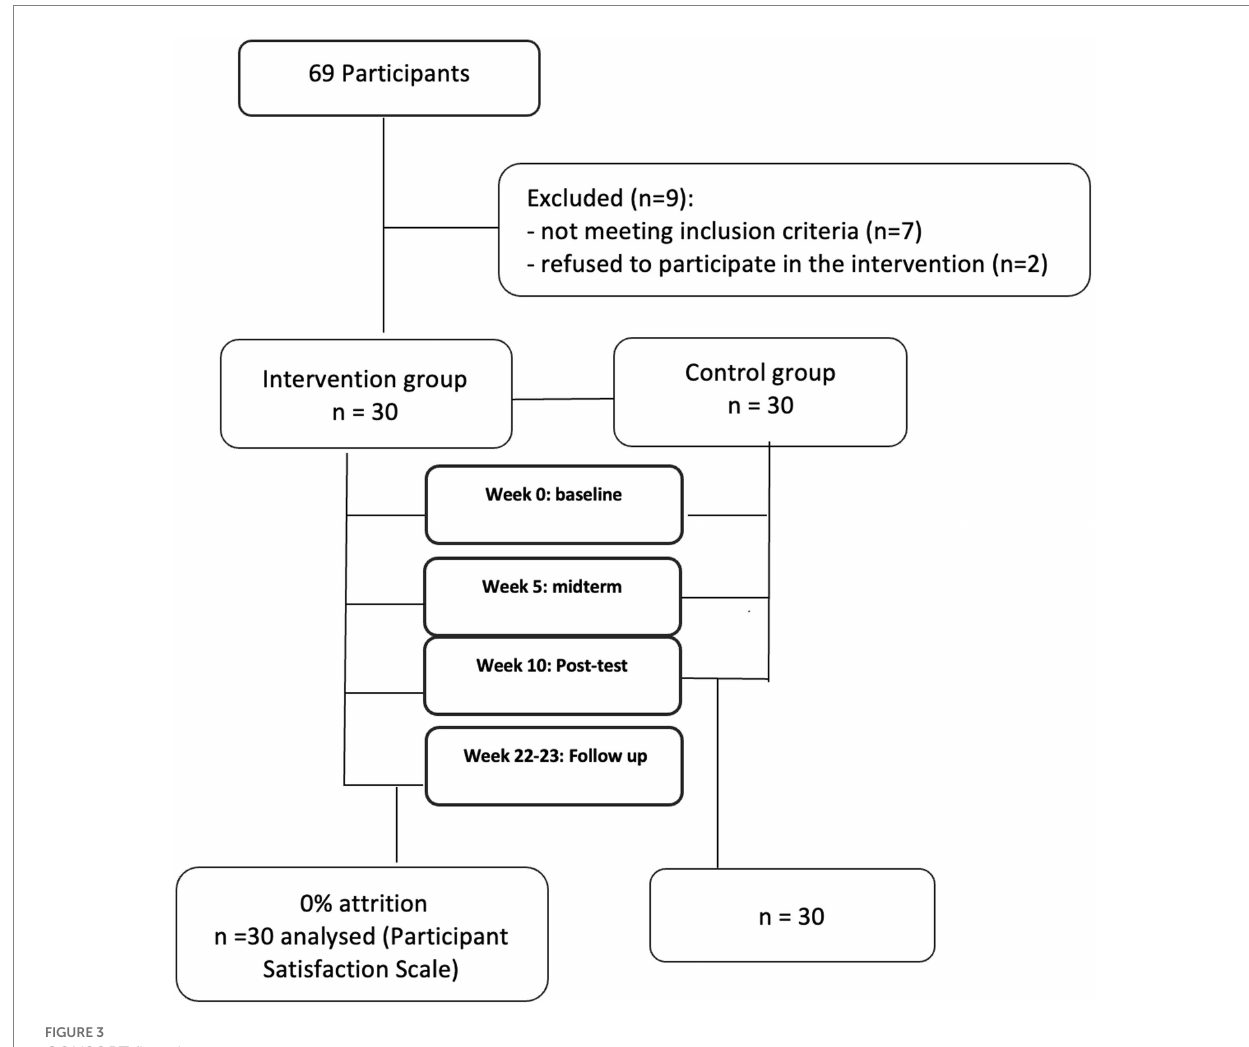
FIGURE 3 CONSORT